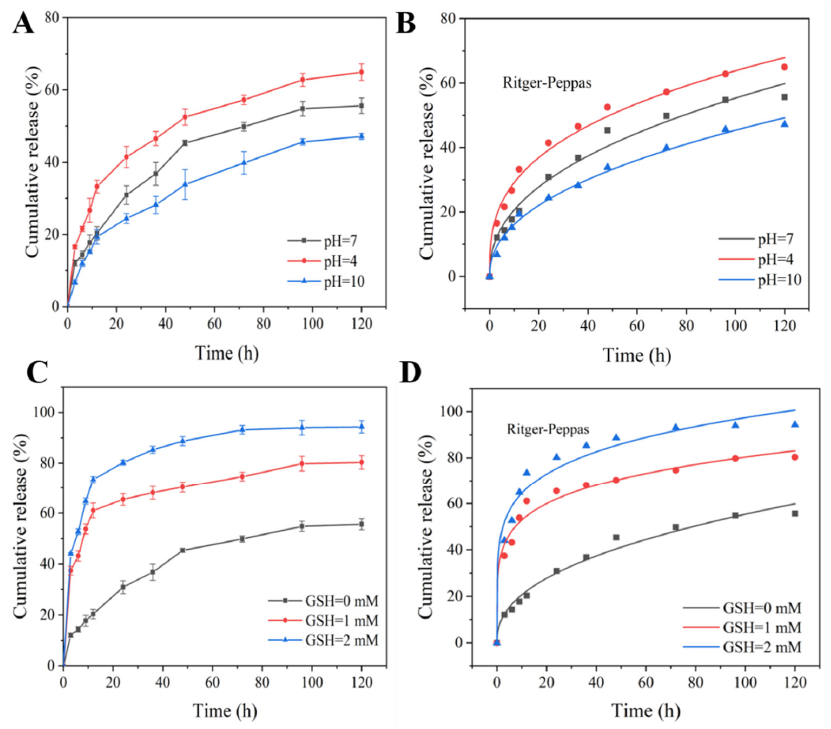
Figure 7. Cumulative release curves and Ritger-Peppas models of Pro@BMMs-SS-Py/ β -CD NPs with different ( A , B ) pH and ( C , D ) GSH values.